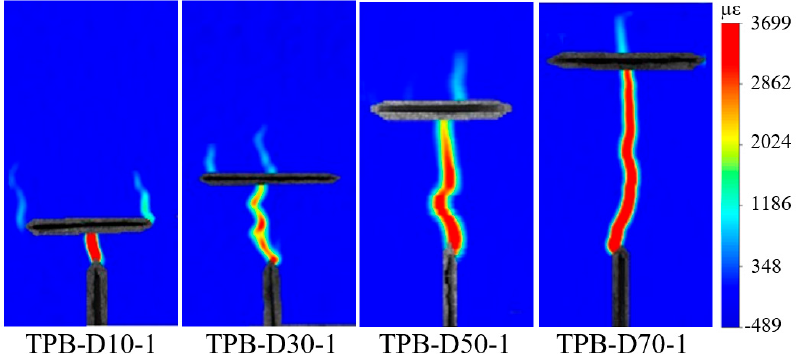
Figure 8. Strain contours in the computational domain on the beams with different preset crack positions.